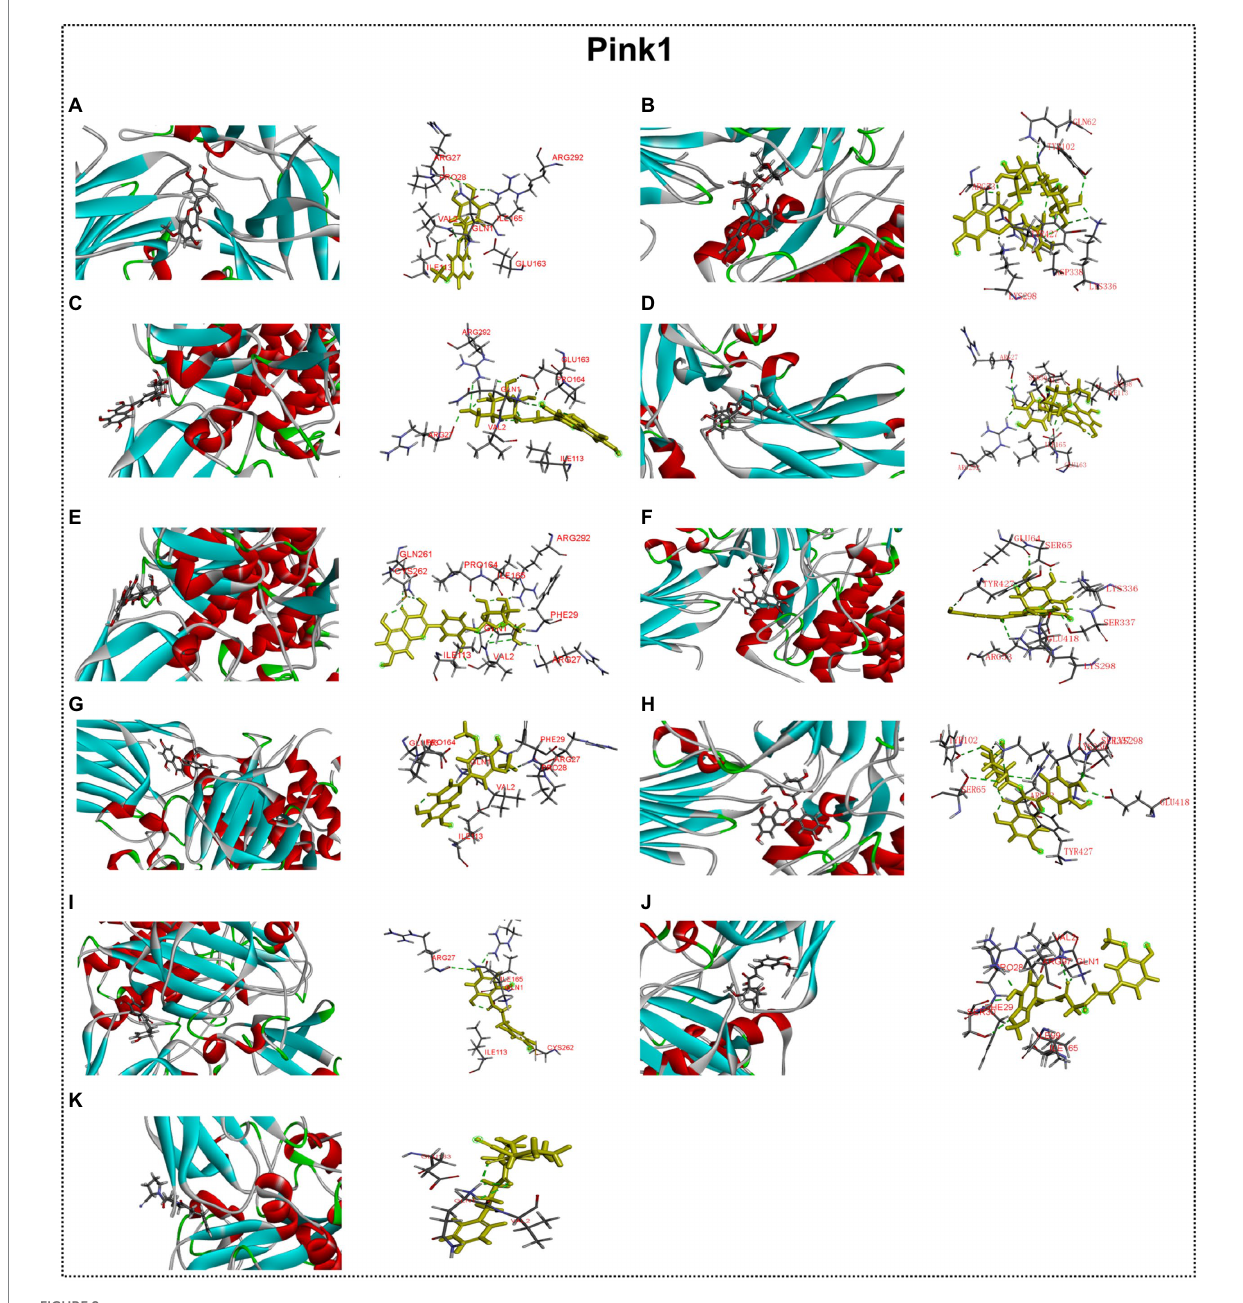
FIGURE 8 Docking simulation of the interaction between main flavonoid compounds of ECoL and the receptor Pink1 in general overview and local overview. Di-O-methylquercetin (A) , rutin (B) , quercetin-3’-O-glucoside (C) , isoquercitrin (D) , spiraeoside (E) , myricitrin (F) , tricin (G) , hyperoside (H) , phloretin (I) , curcumin (J) , and KYP-2047 (K) were used as molecularly docked